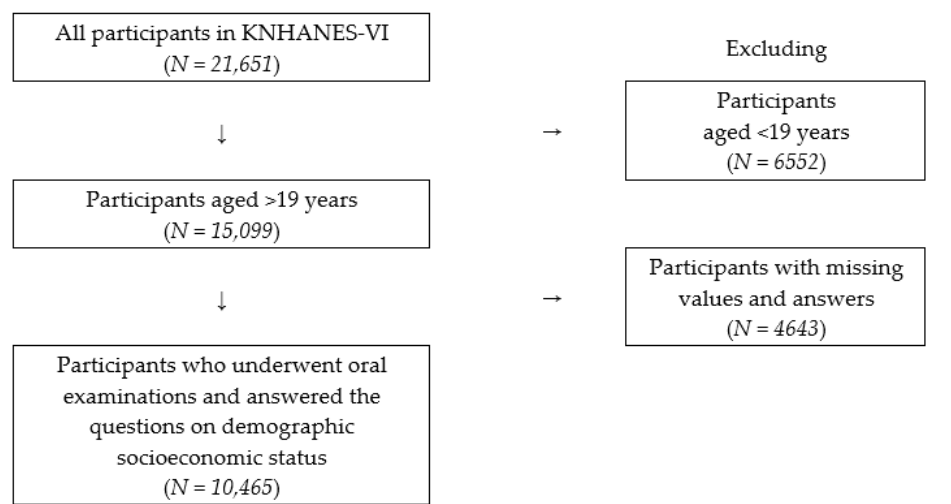
Figure 1. Flowchart for sampling of study participants (KNHANES-VI: Sixth Korea National Health and Nutrition Examination Survey).